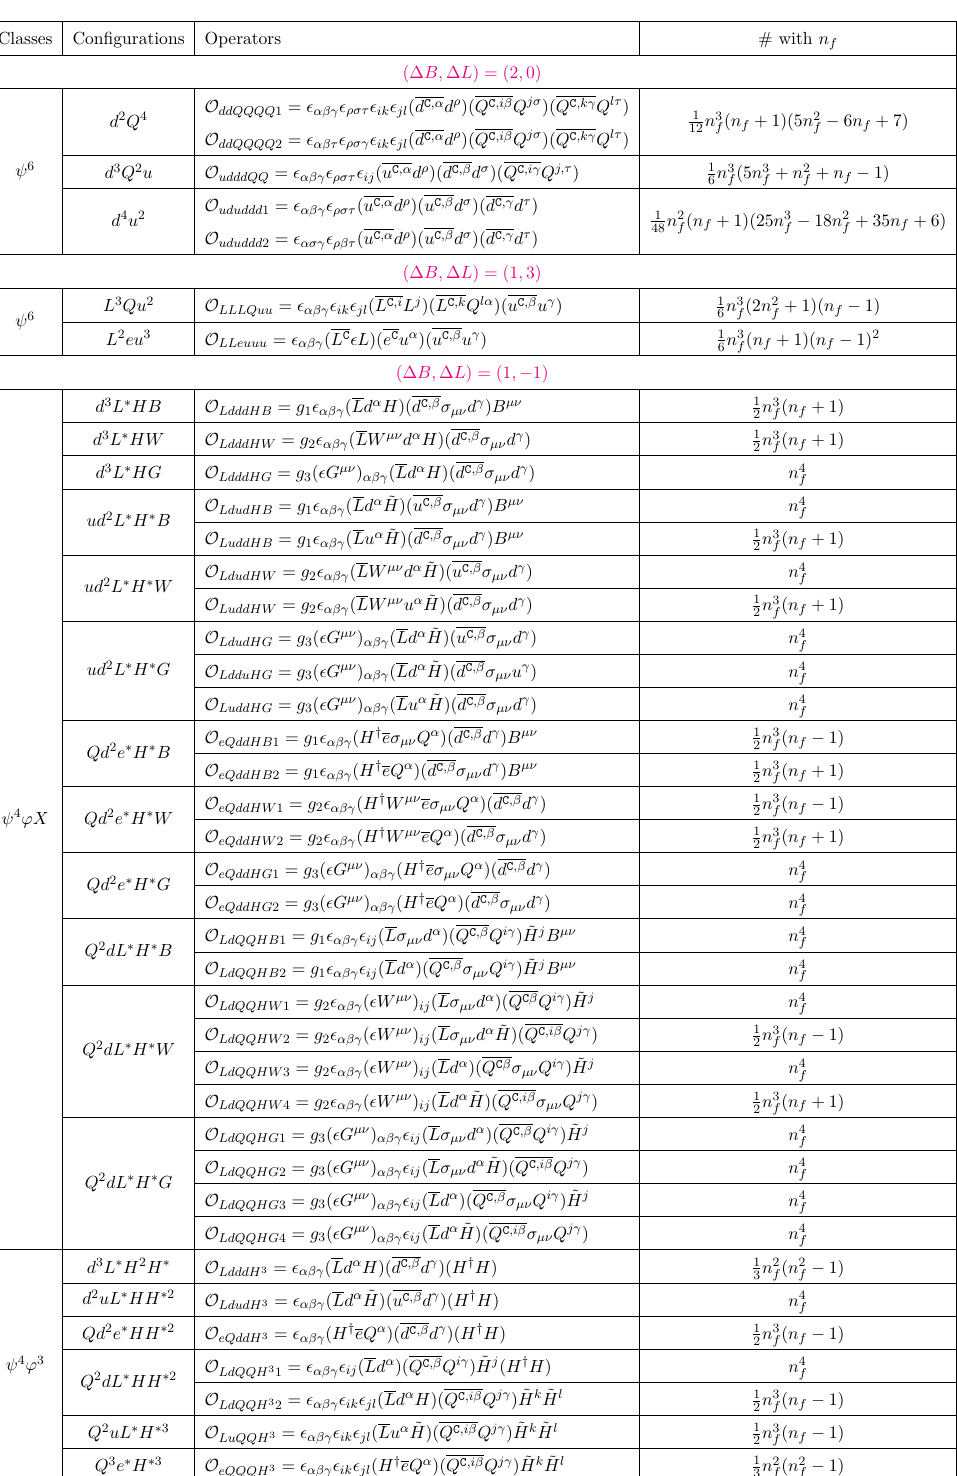
Table 7 . Dim-9 operators in sectors (∆ B, ∆ L ) = (2 , 0) , (1 , 3) , and in classes ψ 4 ϕX, ψ 4 ϕ 3 for sector (∆ B, ∆ L ) = (1 , − 1) . There are 40 operators without counting fermion generations and 29 remain for one generation case. Hermitian conjugated operators are not included or